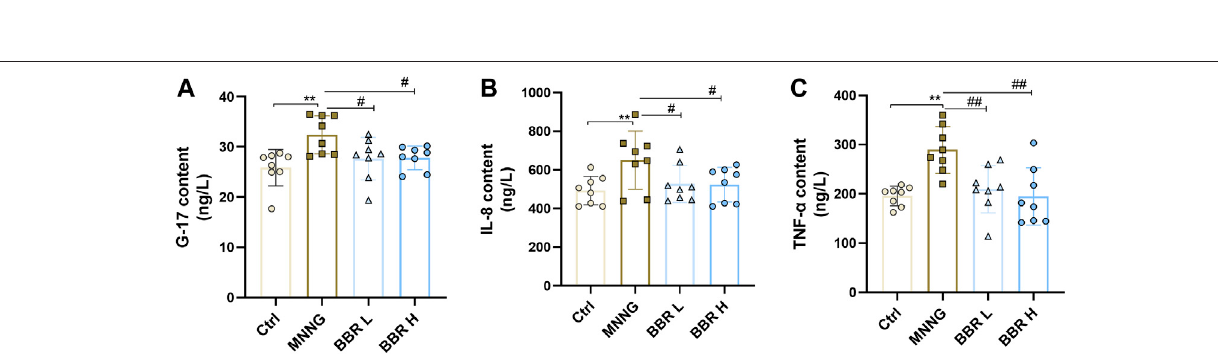
Frontiers in Pharmacology |